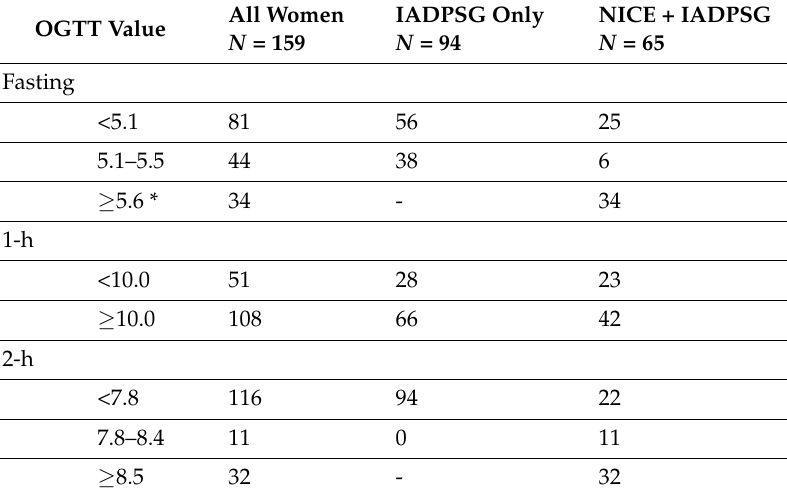
* NICE threshold for fasting blood glucose